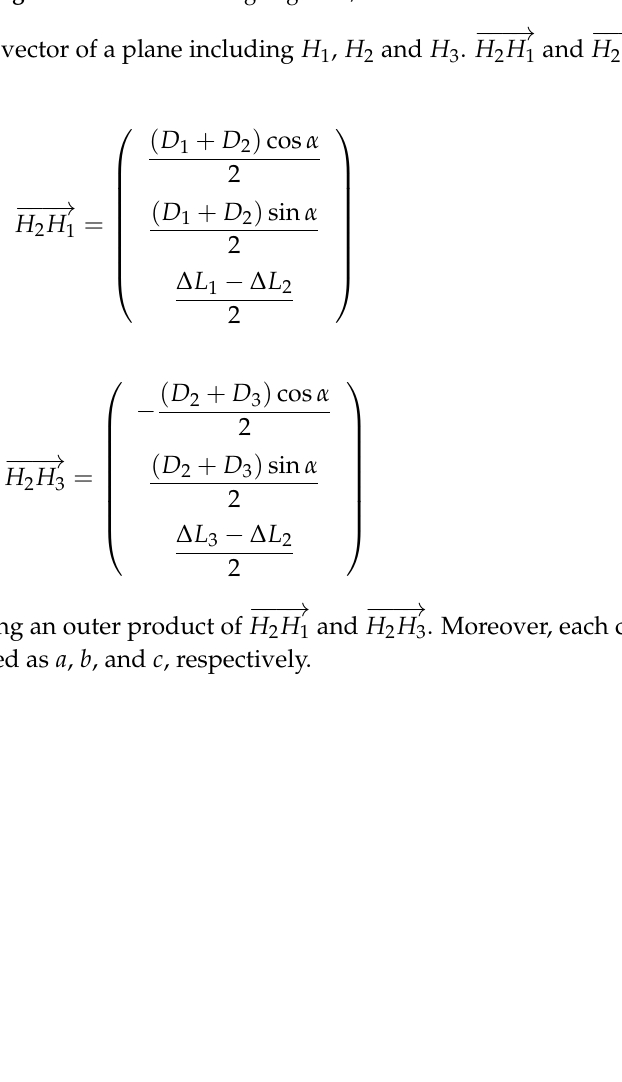
Figure 6. Divided bending angle ∆ θ